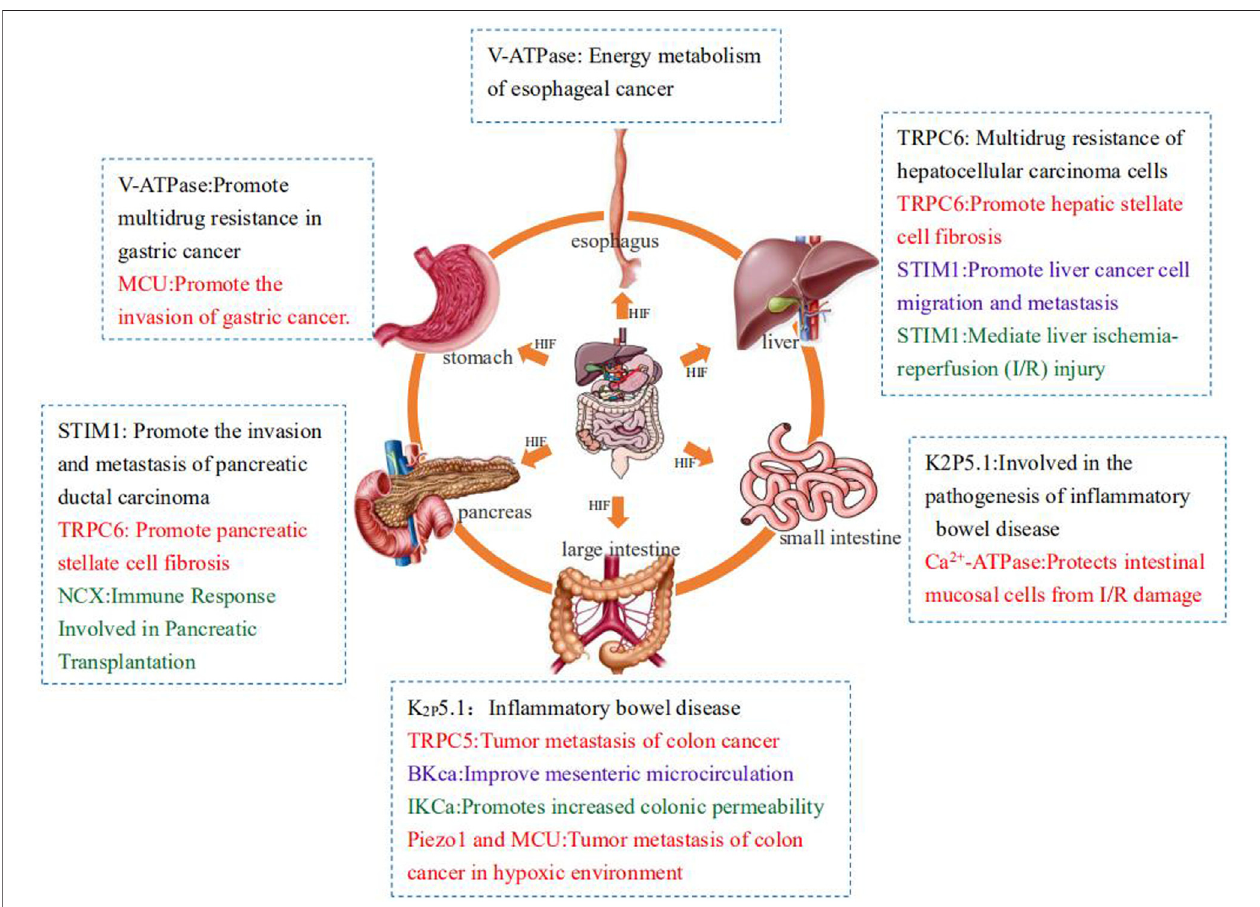
FIGURE 2 | Summary of the effects of ion transporters on the digestive system under hypoxia.